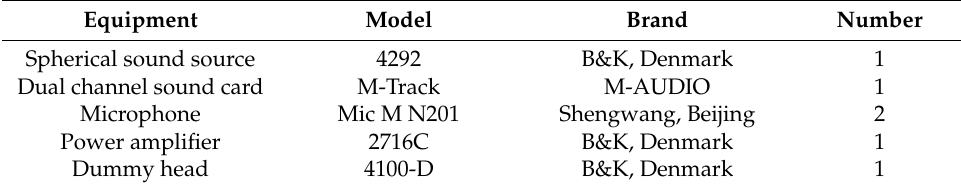
Table 1. Experimental apparatus for binaural signal collection in the